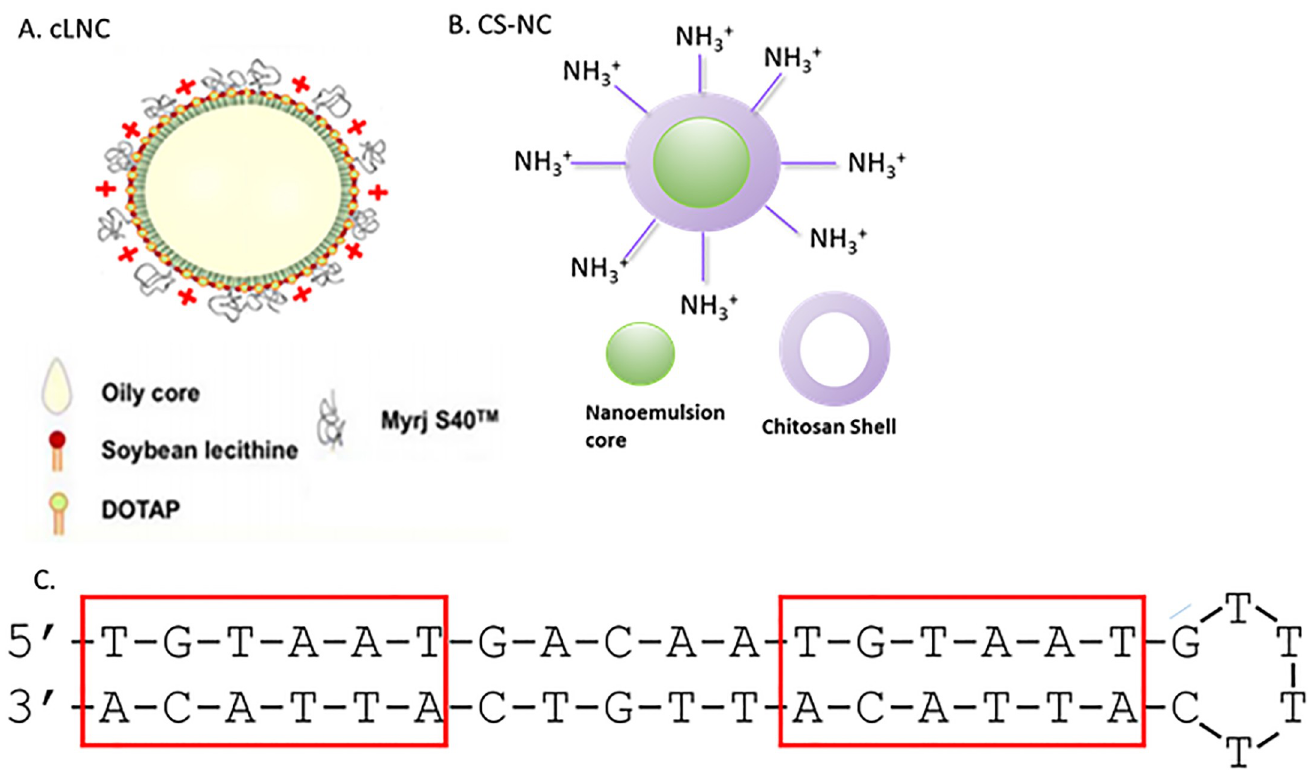
Fig 2. Composition of nanoparticles tested for TFD delivery. A) cationic nanostructured lipid carriers and B) chitosan based nanocarrier (CS-NCs) and C) Structure and properties of the WalR TFD (redrawn from [17, 22]).